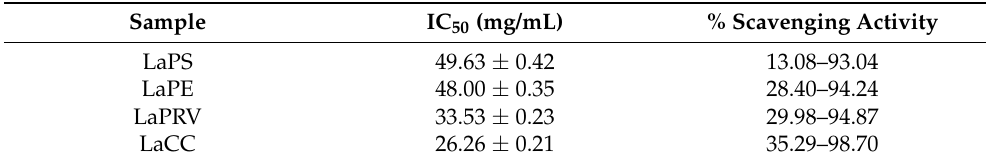
Table 4. IC 50 values (mg/mL) and scavenging activity range (%) of the four lavender EOs